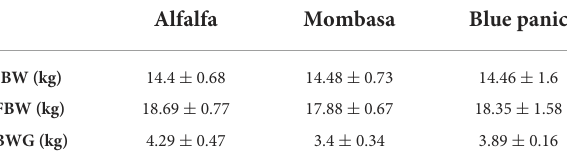
TABLE 4 Blood hematology in growing goats fed alfalfa, Mombasa, or blue